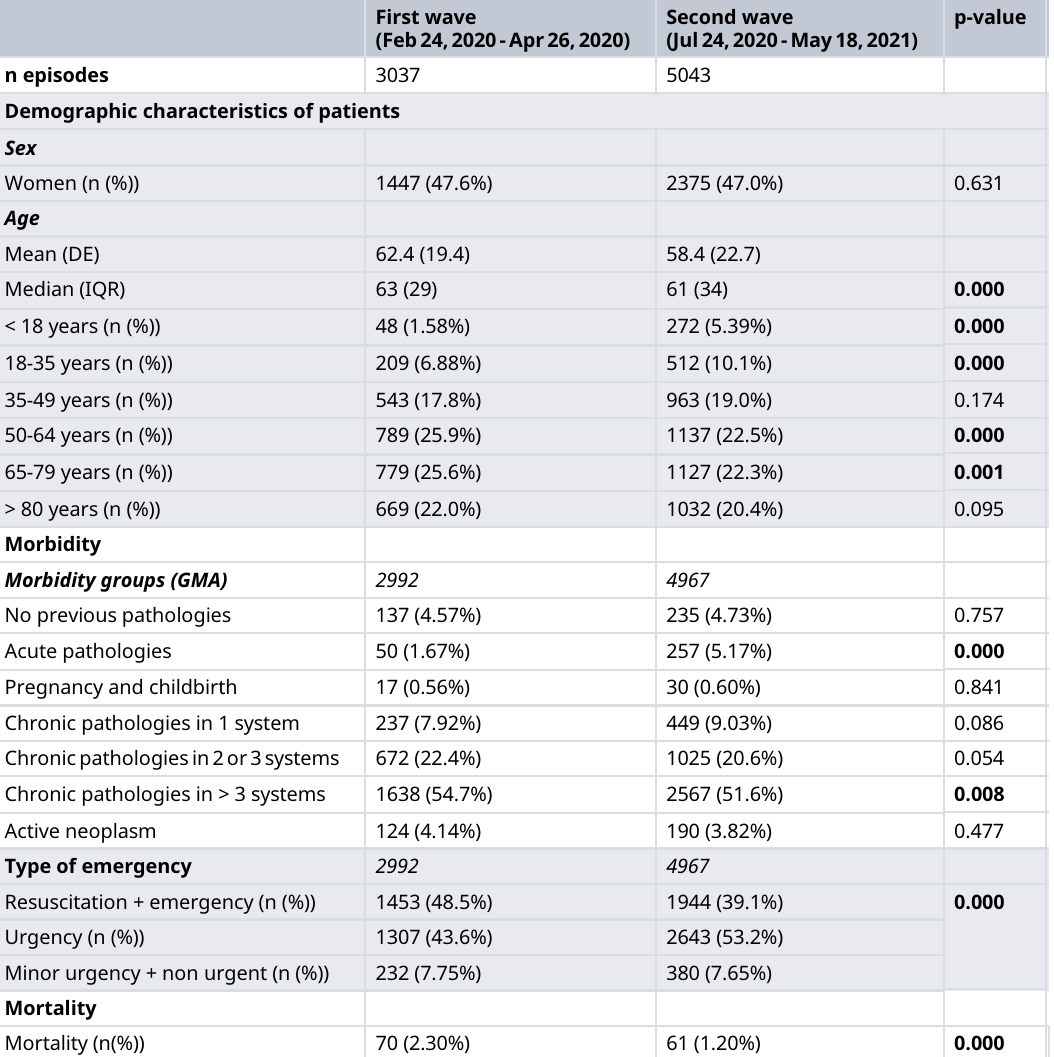
Table 1. Characteristics, type of emergency and mortality of COVID-19 patients entering the hospital. IQR = interquartile range; GMA = adjusted mortality group. Bold p-values represent statistically significant